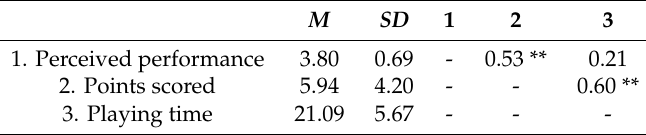
Figure 1. Confirmatory factor analysis of the Perceived Performance in Sports Questionnaire. Table 2. Descriptive statistics and bivariate